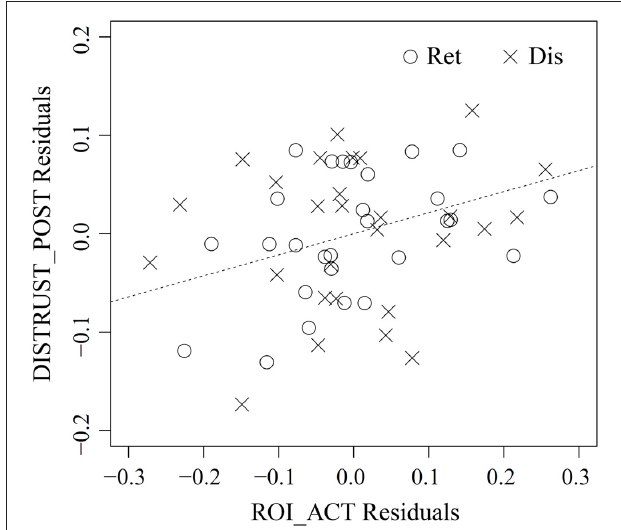
FIGURE 6 | Partial regression plot between vlPFC activity in response to the people with bad reputation (ROI_ACT) and distrust toward them (DISTRUST_POST) in the retrieval (Ret) and disregard (Dis) sessions of action inference . The abscissa represents the residuals from the regression of ROI_ACT on DISTRUST_PRE and SESS, whereas the ordinate represents the residuals from the regression of DISTRUST_POST on the same two variables. The plot thus illustrates the marginal relationship between ROI_ACT and DISTRUST_POST after the effect of the other variables has been removed (Faraway, 2005). For reference, the dashed line shows DISTRUST_POST Residuals = 0.214 (point estimate of γ 20 from Table 2 ) × ROI_ACT Residuals. See “fMRI Data Analysis” Section for more detailed descriptions of each